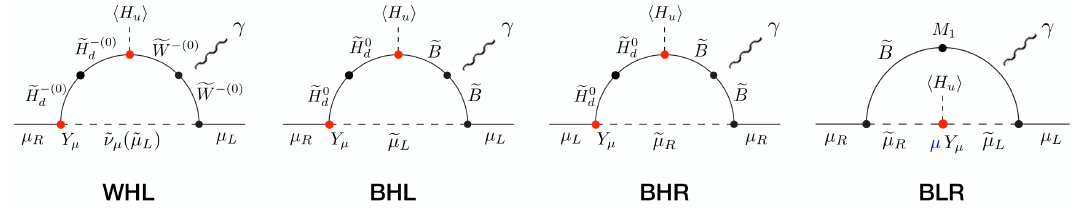
Figure 1 . One-loop diagrams representing SUSY contribution to ( g − 2) µ . Each diagram is labelled by the name corresponding to sparticles taking part in it, e.g. BHL is a diagram involving Bino, Higgsino and left-handed slepton. The red dots represent the interactions responsible for the tan β